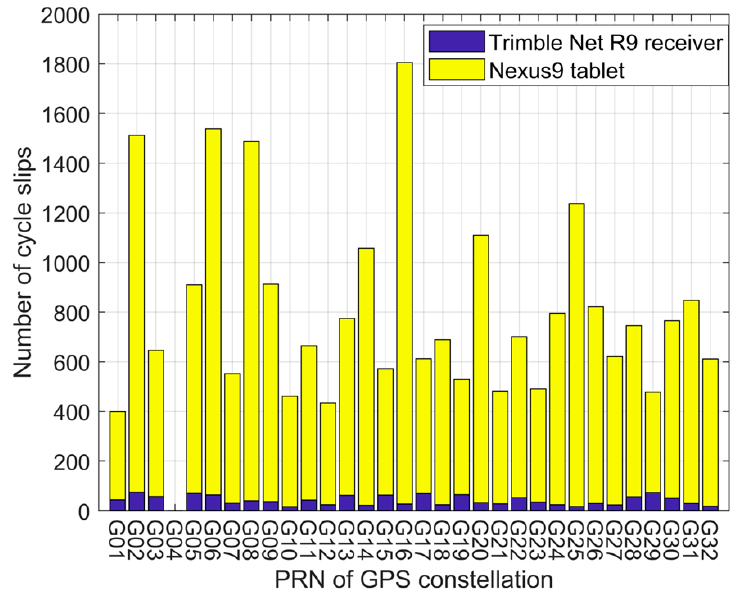
Figure 1. Cycle slips of carrier-phase observations over 24